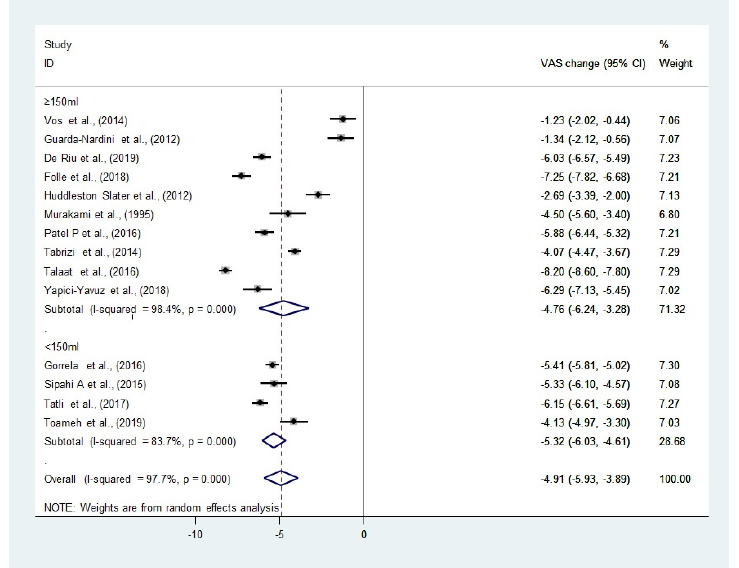
Figure 3. Forest plot using the random effects models showing the weighted mean difference (WMD) in the VAS between the two groups: all studies included. (Heterogeneity between the studies quantified using I 2 and the p -value of the Chi 2 test were listed)